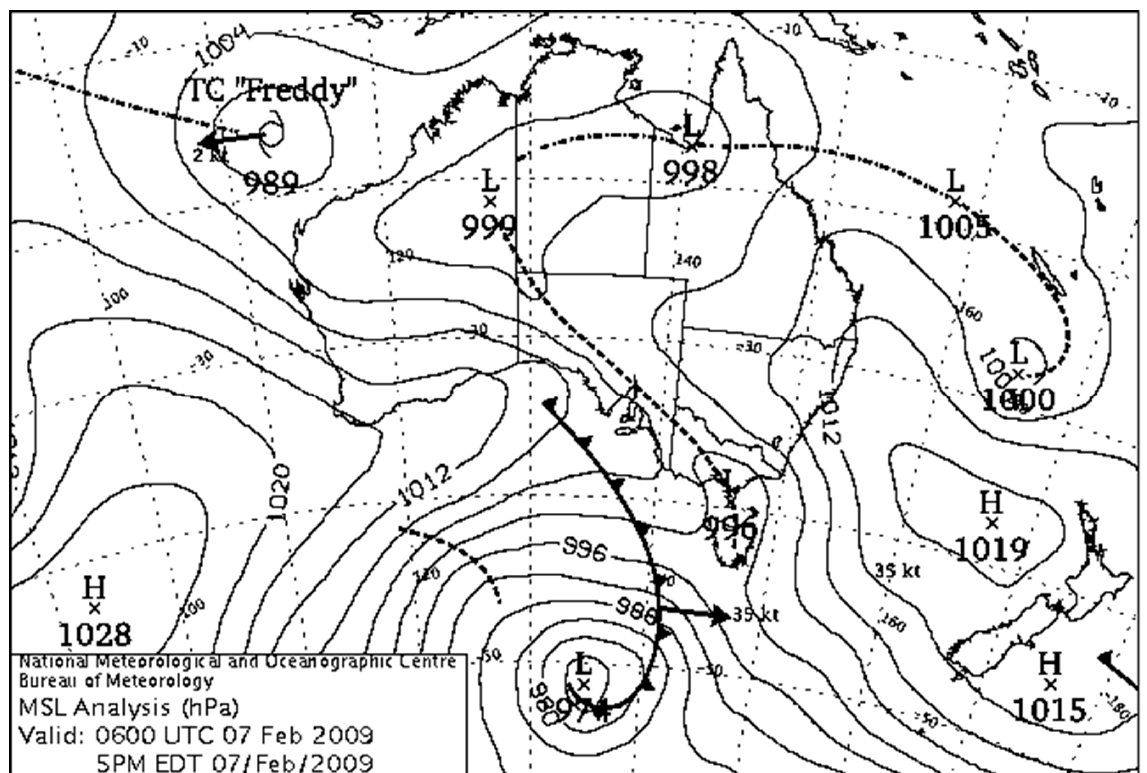
Figure 5. The Black Saturday synoptic features represented by mean sea level pressure (MSLP) analysis at 1700 local time (LT) on 7 February 2009 [105].